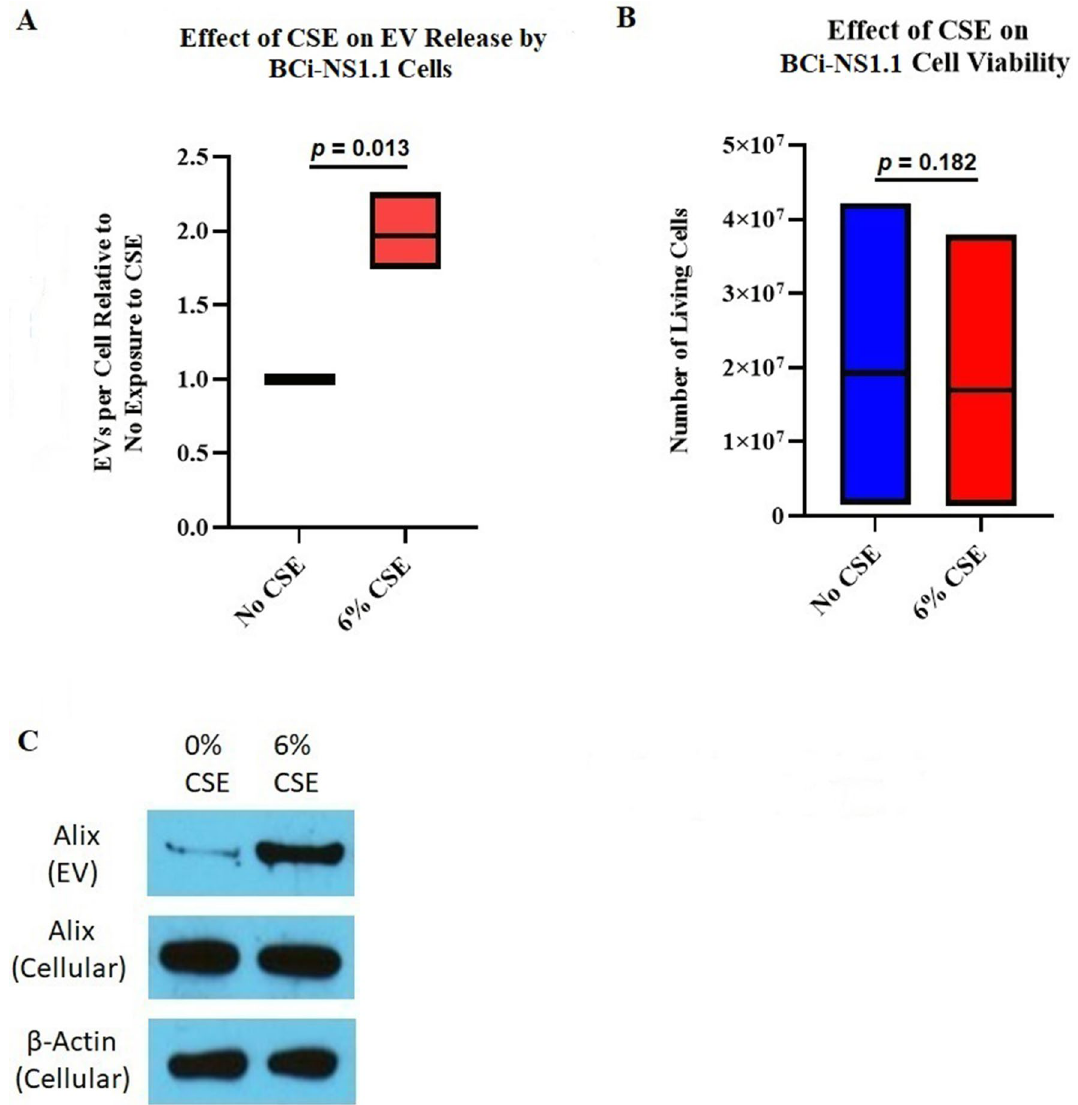
Figure 2. CSE stimulates release of EVs from immortalized human airway basal cells in culture. ( A ) , Floating bar graph depicting 3 replicate experiments quantifying EVs isolated from BCi-NS1.1 cells incubated with 6% CSE, compared with those isolated from cells with 0% CSE. The horizontal line inside the floating bar represents the mean of the 3 experiments. Roughly twice as many EVs per cell were seen after CSE exposure; the P value (two-tailed) was calculated using the ratio paired t test, with P ≤ 0.05 considered statistically significant. ( B ) , Floating bar graph depicting the number of living BCi-NS1.1 cells just prior to EV isolation in the 3 experiments from A. The horizontal lines inside the floating bars represent the means of the 3 experiments. The P value (two- tailed) was calculated using the paired t test, with P ≤ 0.05 considered statistically significant. ( C ) , Immunoblots (cropped for clarity and conciseness) of the exosomal protein Alix identified in BCi-NS1.1 cell EVs and in cell lysates after exposure to 0% or 6% CSE. Immunoblot of β -actin in cell lysates was used as a control. This experiment was repeated 3 times, with representative images shown. Equal amounts of total protein were loaded into each cell-lysate lane, and equal volumes of EV preparations were loaded into each EV lane. In equal volumes of EV preparations, more Alix protein was seen in those from CSE-exposed